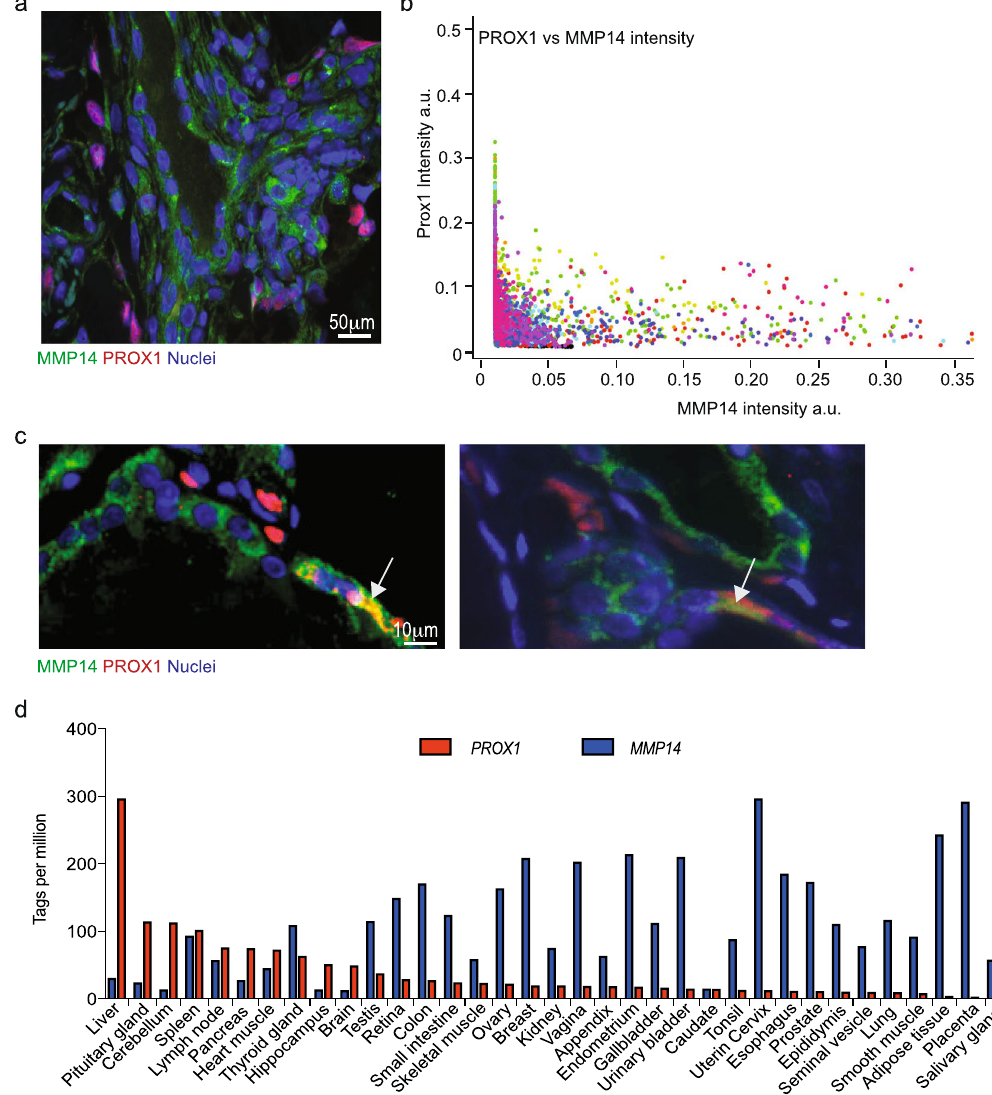
Figure 1. PROX1 and MMP14 expressions are inversely correlated. ( a ) Representative image of a KS section from an AIDS patient stained with MMP14 (green) and Prox1 (magenta) specific antibodies. Nuclei were counterstained with Hoechst 33342. ( b ) MMP14 and Prox1 signal intensities for each cell were quantified from 3 images/section of 10 different patients. Each dot represents a cell and the different colours represent the different patients. ( c ) 57 specimens from TMA were stained as in ( a ), representative images are shown for one benign hyperplasia (left) and one papillary thyroid cancer (right). White arrows indicate cells with Prox1 cytoplasmic staining. ( d ) Transcript levels of Prox1 and MMP14 in different tissues/organs derived from FANTOM5 database. Tags per million for MMP14 (Blue) and Prox1(red) are shown for each tissue/organ. Pearson´s correlation coefficient (r): − 0.4515. Significance of the correlation p =